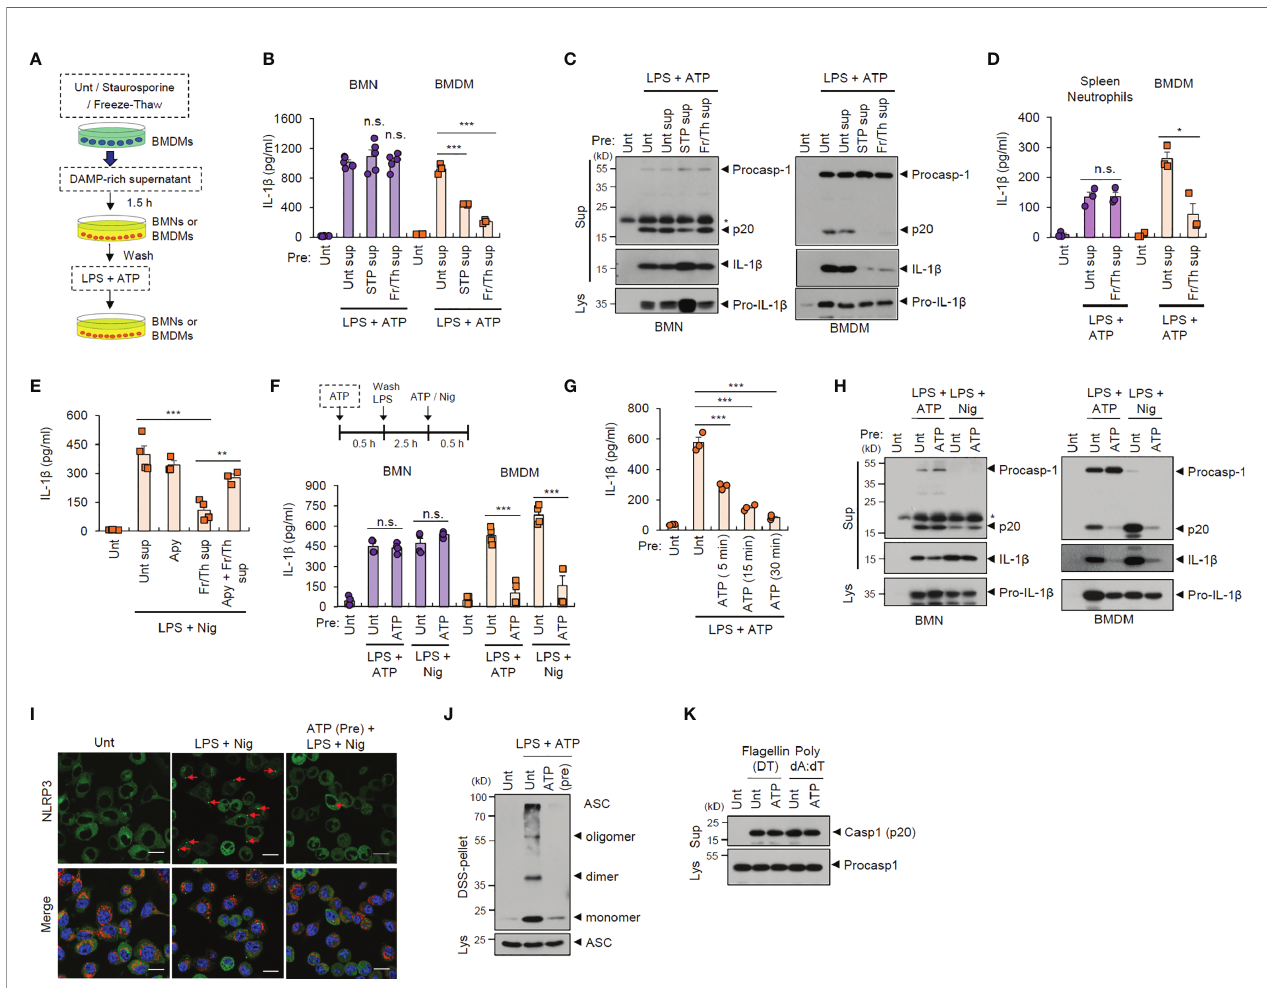
FIGURE 2 | Danger signal-rich medium pretreatment desensitizes NLRP3 in fl ammasome-activating potential of macrophages but not neutrophils. (A) Experimental scheme for determining the potential effect of cell-free supernatants from normal BMDMs or those injured by staurosporine (STP) or repeated freeze/thaw cycles on NLRP3 in fl ammasome activation of neutrophils or macrophages. (B) Quanti fi cation of IL-1 b in the culture supernatants of mouse BMNs or BMDMs pretreated with cell-free supernatants from untreated or injured BMDMs as in (A) and then treated with LPS (0.25 m g/mL, 2.5 h) followed by ATP (2.5 mM, 30 min) treatment ( n = 5, BMNs; n = 3, BMDMs). (C) Immunoblots from mouse BMNs or BMDMs treated as in (B) . The asterisk indicates a nonspeci fi c band. (D) Quanti fi cation of IL-1 b in the culture supernatants of mouse splenic neutrophils or BMDMs pretreated with cell-free supernatants from untreated or injured BMDMsa by freeze/thaw cycles (2.5 mM, 30 min), and then treated with LPS, followed by ATP (2.5mM, 30 min) treatment ( n = 4). (E) Quanti fi cation of IL-1 b in the culture supernatants of mouse BMDMs pretreated with DAMP-rich medium by freeze/thaw cycles in the presence of apyrase (15 U/ml), and then treated with LPS followed by nigericin (5 m M, 40 min) treatment ( n = 3 or 4) (F) Quanti fi cation of IL-1 b in the culture supernatants of mouse BMNs or BMDMs pretreated with ATP (2.5 mM, 30 min), washed and treated with LPS (0.25 m g/mL, 2.5 h), followed by ATP (2.5mM, 30 min) or nigericin (Nig, 5 m M, 40 min) treatment ( n = 4). (G) Quanti fi cation of IL-1 b in the culture supernatants of mouse BMDMs pretreated with ATP (5, 15, 30 min), and then treated with LPS, followed by ATP treatment ( n = 3). (H) Immunoblots from mouse BMNs or BMDMs treated as in (F) . (I) Representative immuno fl uorescence images of NLRP3-GFP-expressing immortalized BMDMs pretreated with ATP (2 mM, 30 min) and then treated with LPS (0.25 m g/mL, 3 h), followed by nigericin (Nig, 5 m M, 30 min) treatment after anti-Tom20 antibody staining (red). Nuclei were stained with DAPI (blue). Scale bars, 20 m m. Red arrows indicate NLRP3-oligomerized specks. (J) Immunoblots of DSS-crosslinked pellets (DSS-pel) or cellular lysates (Lys) from BMDMs pretreated with ATP (2.5 mM, 30 min) and then treated with LPS (0.25 m g/mL) and ATP (2.5mM). (K) Immunoblots of mouse BMDMs pretreated with ATP (2.5 mM, 30 min) and then transfected with fl agellin (500 ng/mL, 4 h) or poly dA:dT (2 m g/mL, 4 h). Culture supernatants (Sup) or cell lysates (Lys) were immunoblotted with the indicated antibodies. * P < 0.05, ** P < 0.01, *** P < 0.001, n.s. not signi fi